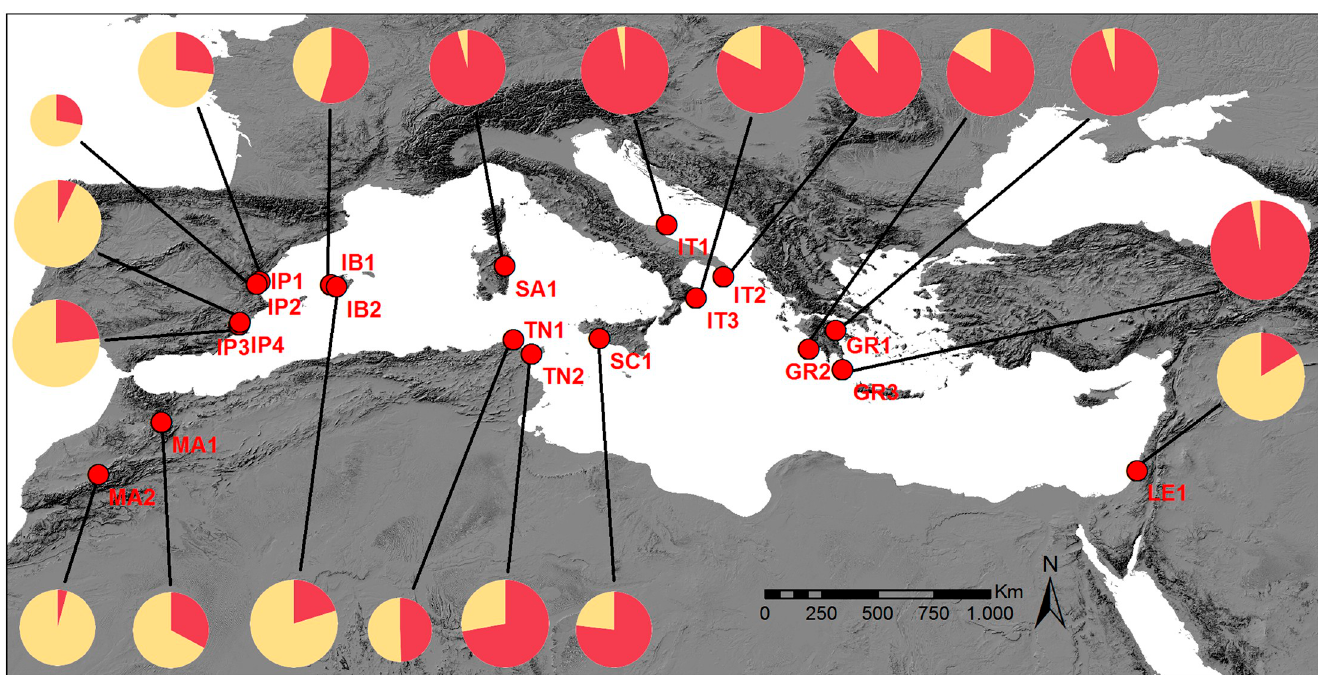
Fig 1. Sampling of Loxosceles rufescens throughout the Mediterranean basin. Circles represent the proportional assignation of microsatellite loci to each genetic cluster. Abbreviations: GR (Greece), IB (Balearic Islands), IP (Iberian Peninsula), IT (Italy), LE (Israel), MA (Morocco), SA (Sardinia), SC (Sicily), TN (Tunisia).